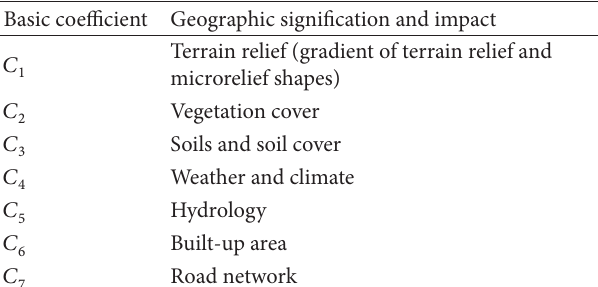
Table 1: Main coefficients of